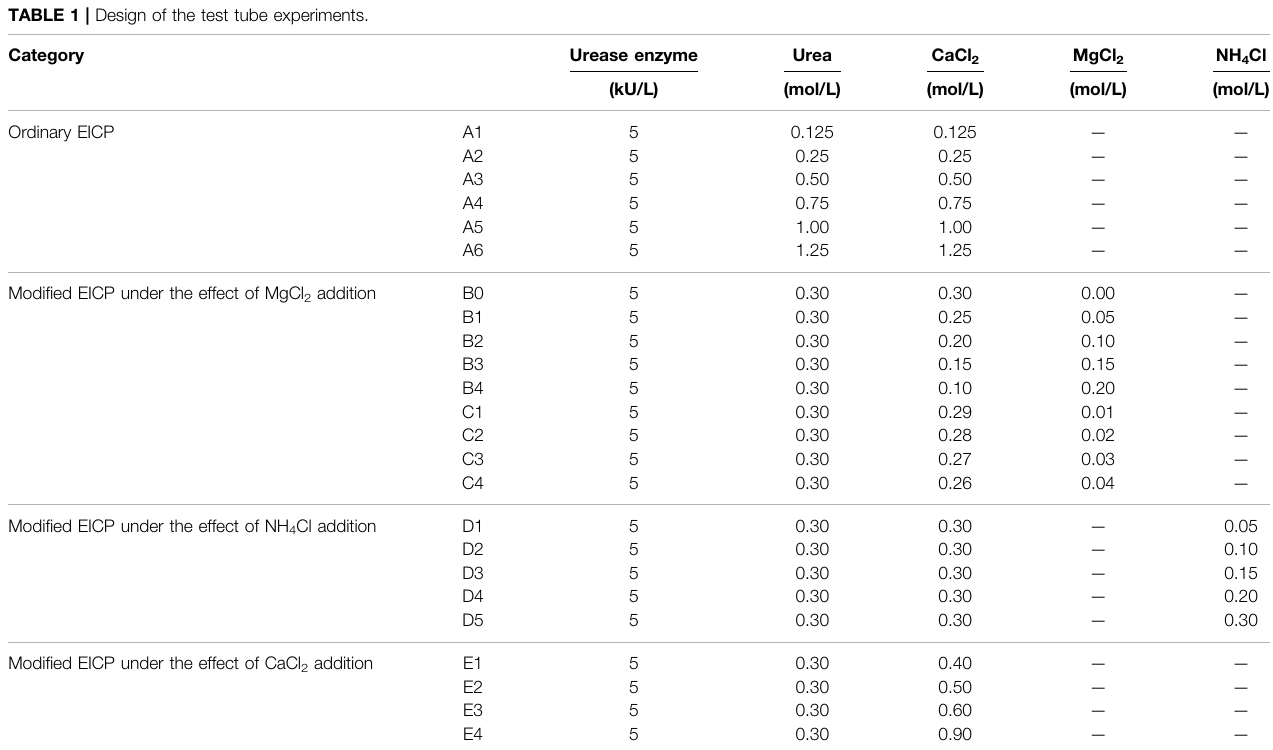
TABLE 1 | Design of the test tube